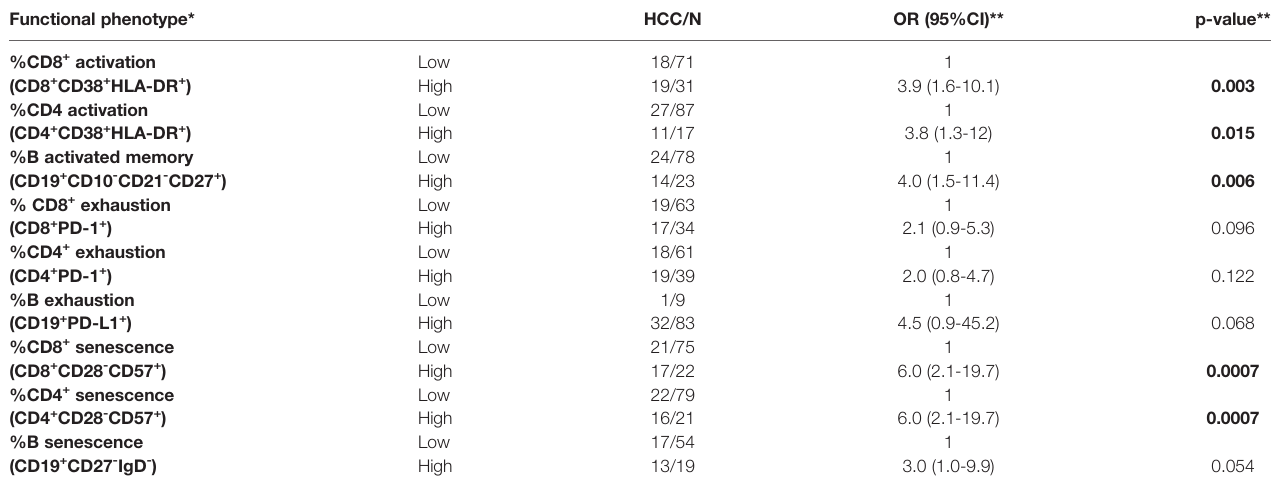
TABLE 2 | Logistic model evaluating the immunological parameters associated with HCC at baseline. Functional